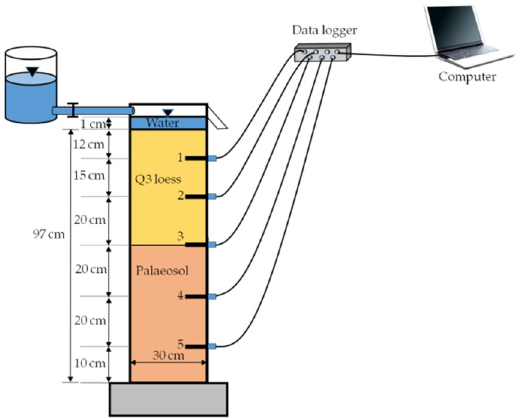
Figure 4. Diagram of the laboratory soil column infiltration experiment.